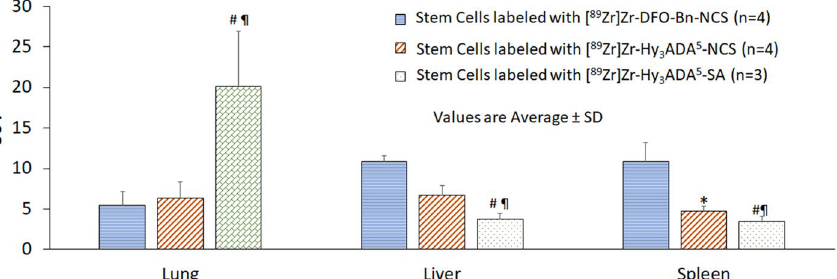
Figure 9. Uptake (SUV) and biodistribution of stem cells labeled with [ 89 Zr]Zr-DFO-NCS, [ 89 Zr]Zr-Hy 3 ADA 5 - NCS and [ 89 Zr]Zr-Hy 3 ADA 5 -SA synthons in lung, liver and spleen of athymic nude mice at day 7 post-injection. *p < 0.05 stem cells labeled with [ 89 Zr]Zr-DFO-Bn-NCS Vs with [ 89 Zr]Zr-Hy 3 ADA 5 -NCS; # p < 0.05 stem cells labeled with [ 89 Zr]Zr-DFO-Bn-NCS Vs [ 89 Zr]Zr-Hy 3 ADA 5 -SA and ¶ p < 0.05 stem cells labeled with [ 89 Zr]